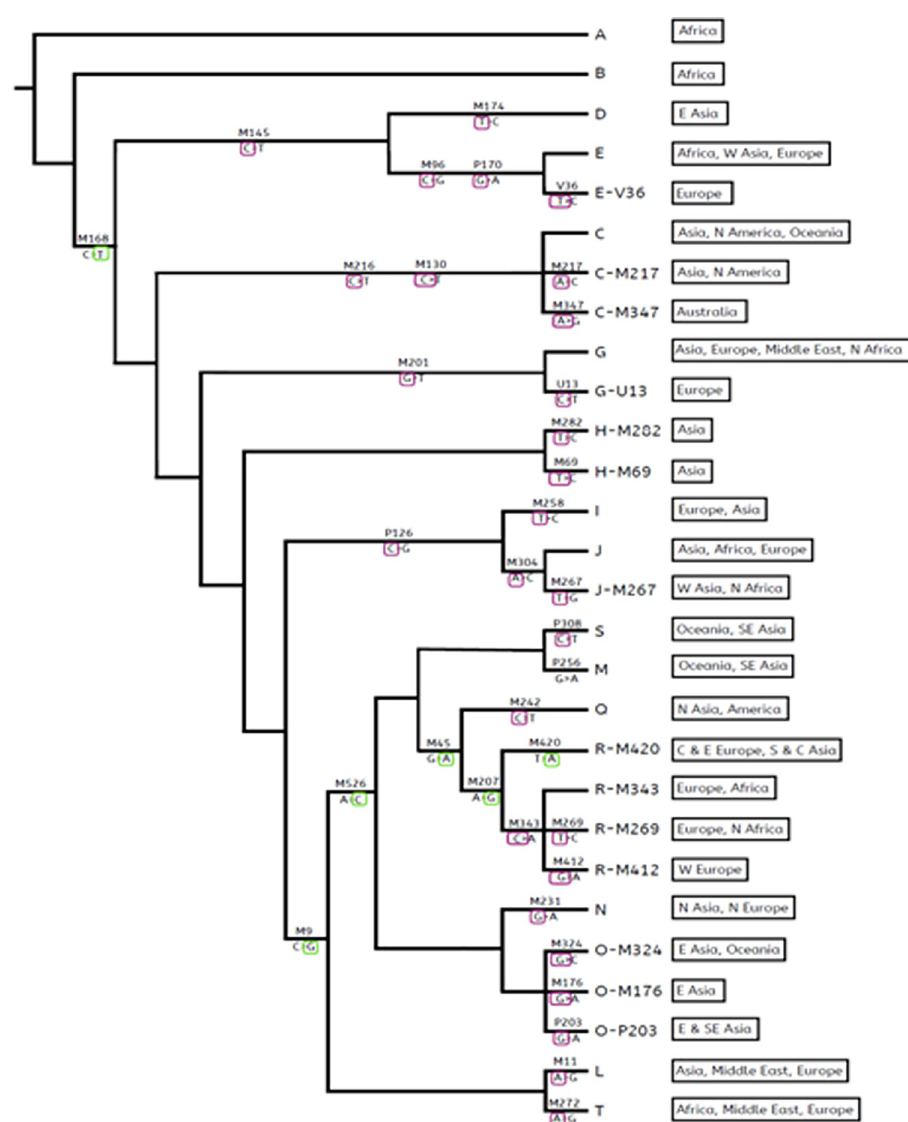
Fig 3. Y-chromosome haplogroup assignment on PhyloTree for sample R1. Haplogroup assigned is R-M420. Derived SNPs: M168(C > T) ! M9(C > G) ! M526(A > C) ! M45(G > A) ! M207(A > G) ! M420(T > A). Purple and green colour circles show ancestral and derived SNPs, respectively. Names on branches and leaves of tree represents SNP identifiers and haplogroup names,